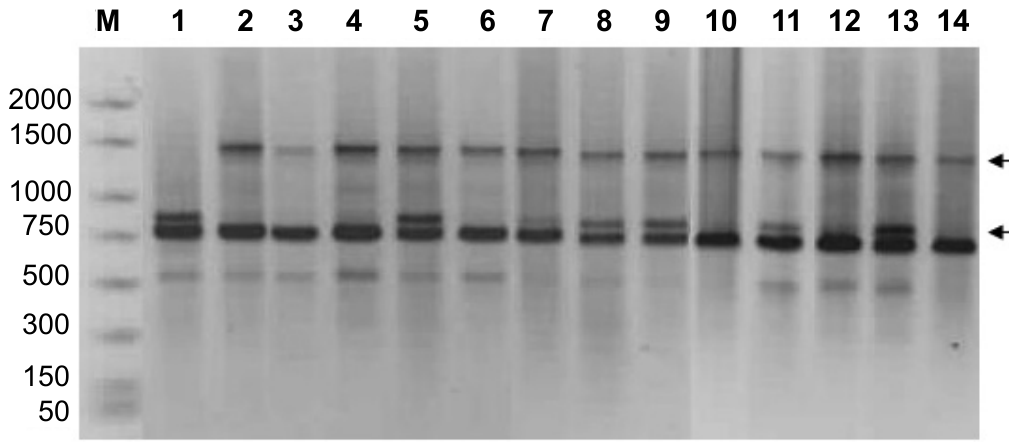
Fig. 1. Random ampli fi ed polymorphic DNA of Phaeomoniella chlamydospora using primer OPE-20; ampli fi ed fragments were separated by 1% agarose gel electrophoresis. Lane 1, reference isolate CBS 161.90b. Lanes 2 to 14: isolates VR3- 2b, VR6-1b, VR39c, Y38-8-1c, Y41-2-2c, Y87-5-3c, Y89-4-2c, Y83-8-1c, Y106-3-3c, Y112-42-3c, Y119-8-5b, Y116-18-3c and Y122-3-6c. Lane M, DNA molecular weight marker (2 Kb); the fragment size is indicated on the left. Markers E-20 1500 bp and E-20 870 bp are indicated by